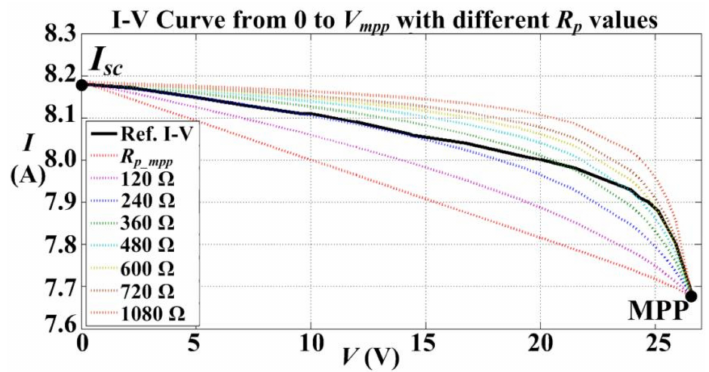
Figure 5. Ref. I-V curves and I-V curves generated at different R p values.